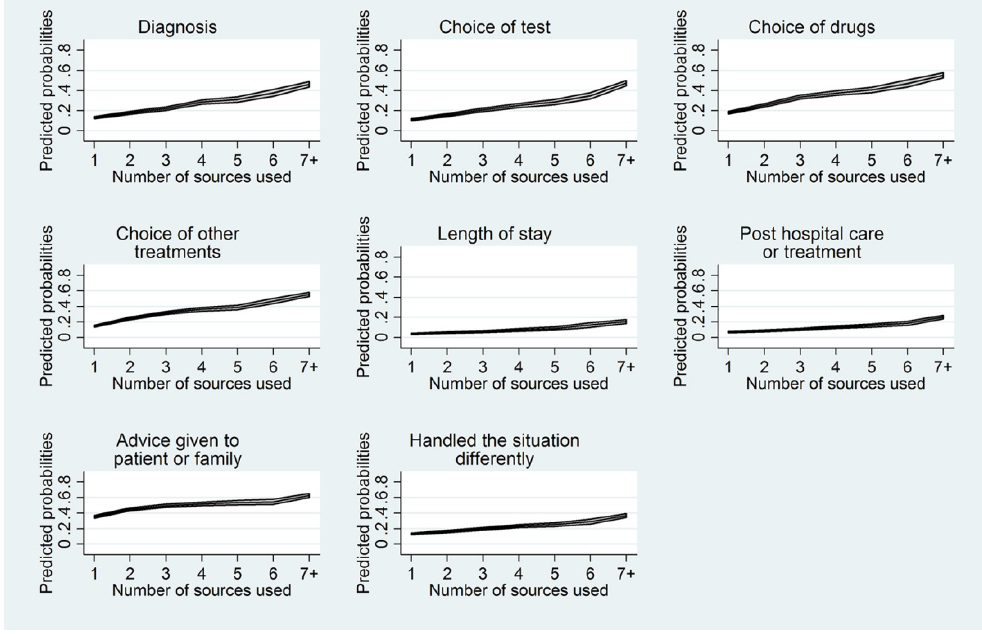
Figure 2 Predicted probabilities for changes made to patient care (with 95% confidence intervals), depending on the number of information resources used